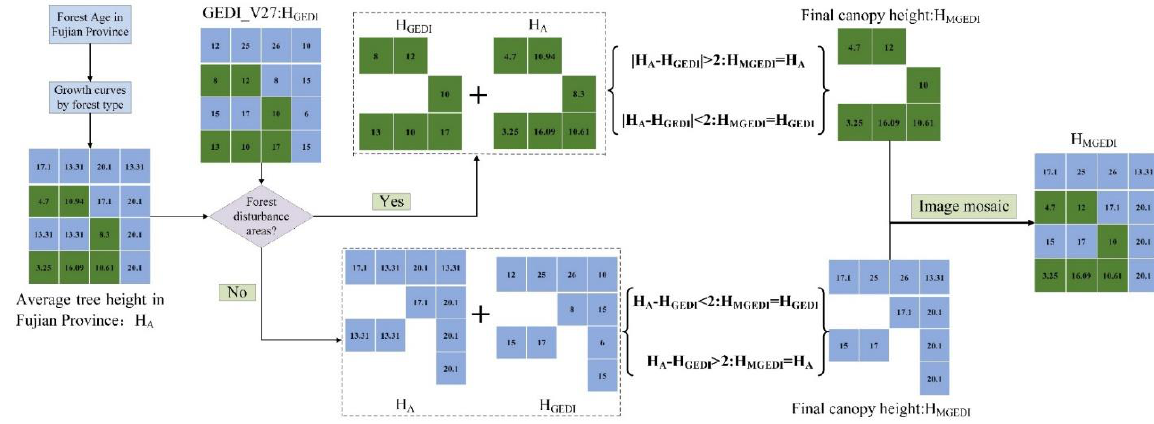
Figure 7. Flow chart for estimating canopy height. The average tree height is expressed as HA, the canopy height of the GEDI_V27 is expressed as HGEDI, and the canopy height of the MGEDI_V27 is expressed as HMGEDI. Green pixels indicate an interference area, and blue pixels indicate a non-interference